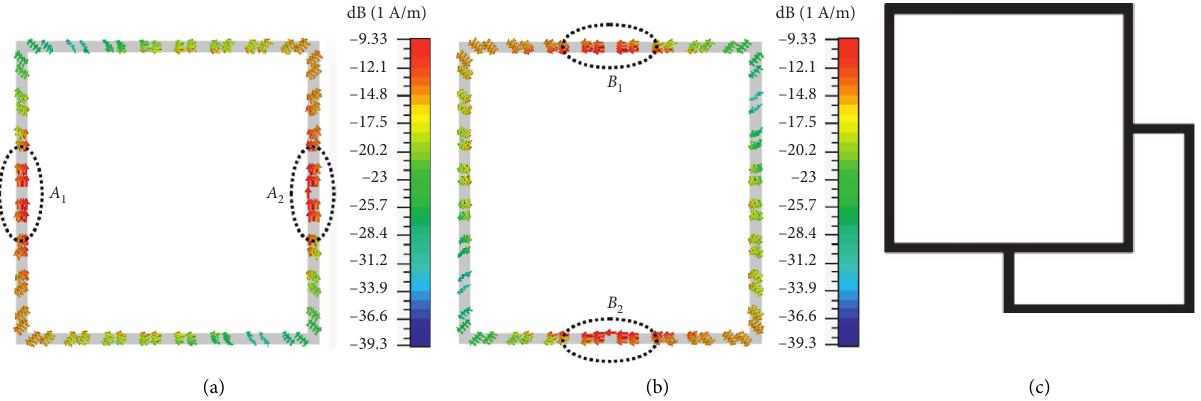
Figure 6: The simulated characteristic currents: (a) mode J 1 , (b) mode J 2 , and (c) cascading square loop feeding